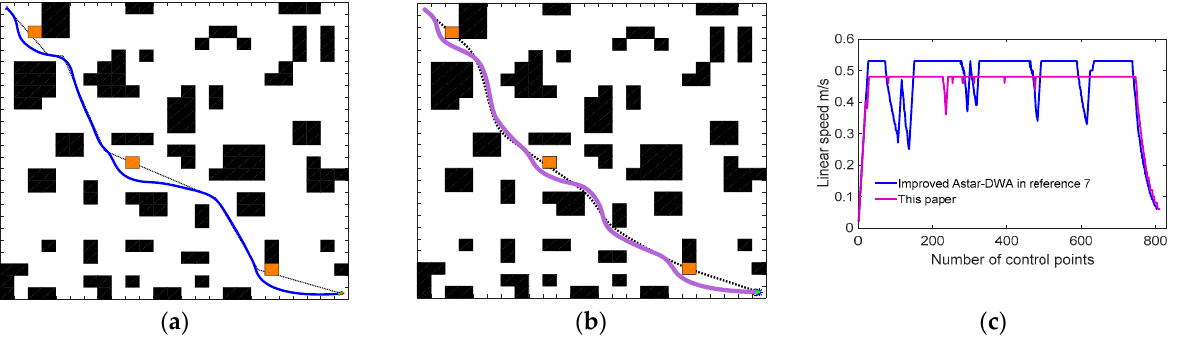
Figure 19. Comparison of path planning results for unknown static environment 2; ( a ) Local path planning [7] ( b ) This paper; and ( c ) Line speed comparison diagram.